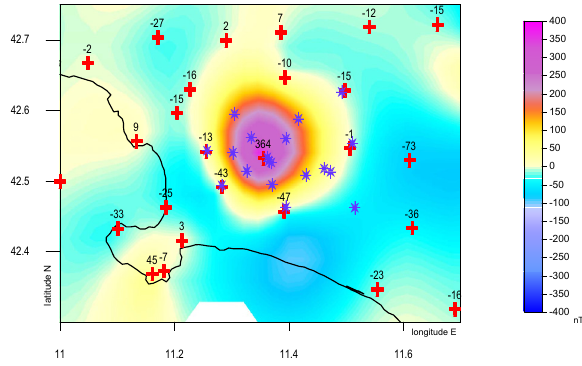
Figure 4. Total intensity anomaly map over Albegna Basin: crosses show the onshore stations from Italian database with the corre- sponding values of anomaly, and blue stars indicate the new meas- urements.